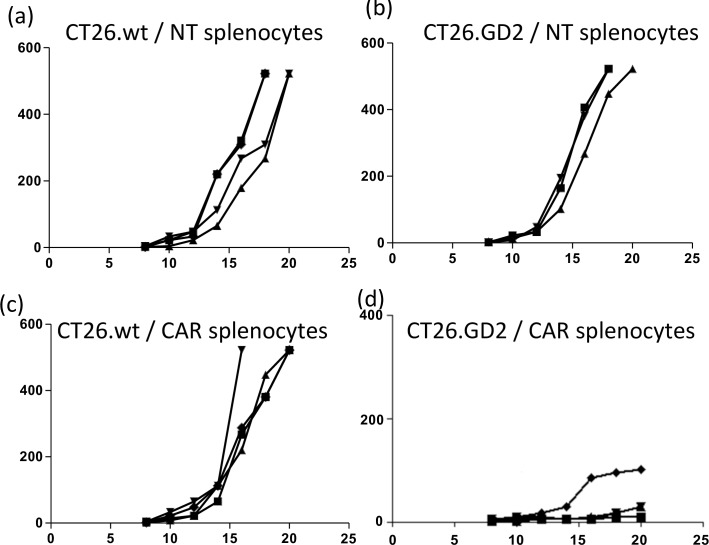
In vivo testing of GD2 CAR.Balb-C mice were innocultaed with 1x106 CT26 or CT26-GD2 cell mixed in matrigel. 10 days post tumour inoculation, mice were sub-lethally irradiated (200 rads) and two weeks post tumour injection, mice were intravenously transplanted with a total of 1.5x106 transduced splenocytes or non transduced controls by tail vein injection. Wild type CT26 were used as antigen negative controls (a,c) whereas CT26 –GD2 tumors treated with untransduced T cells (b) did not regress whilst CT26-GD2 tumors challenged with CAR T cells regressed. Each line represents one mouse.